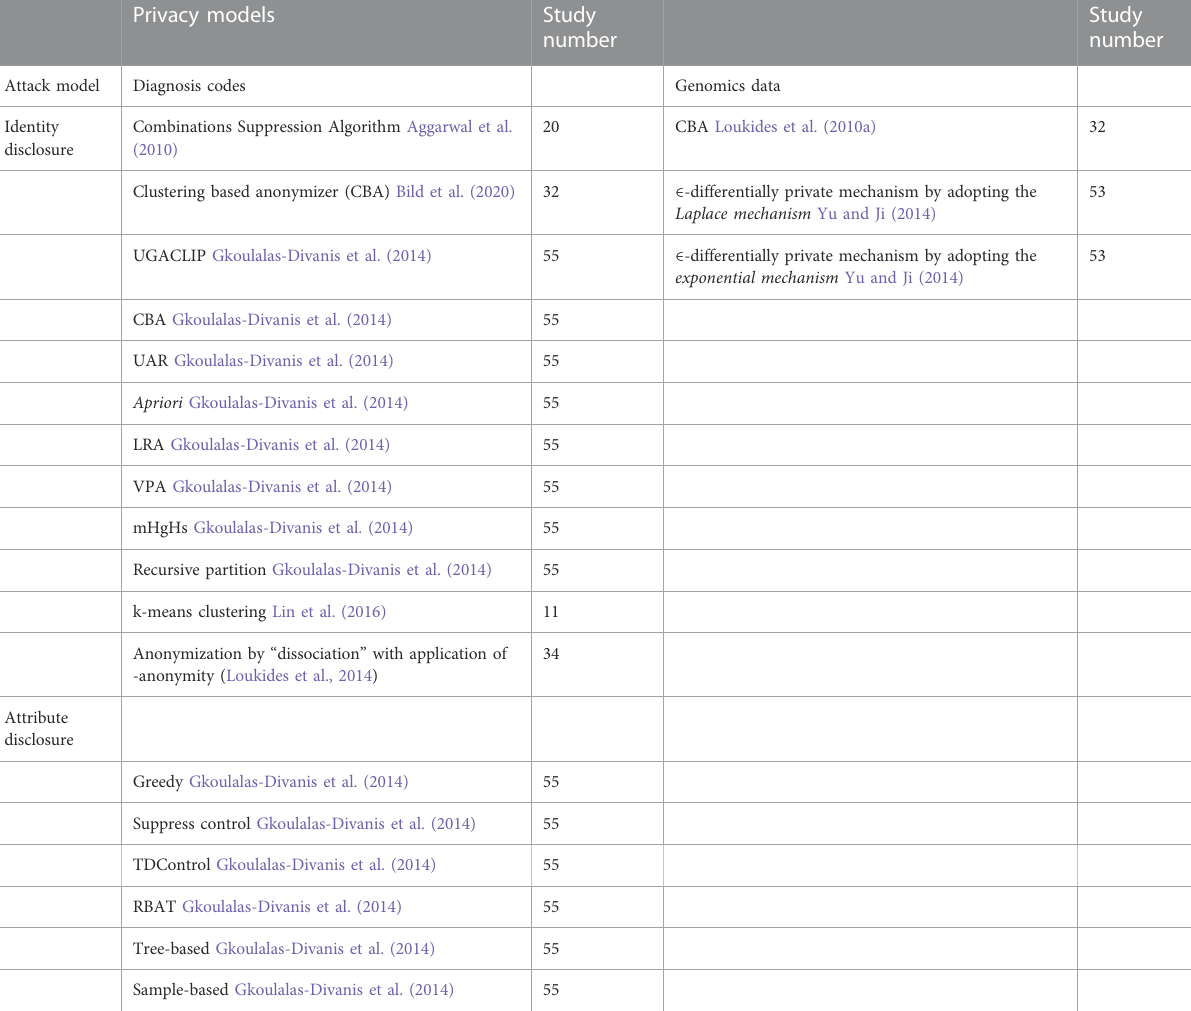
TABLE 2 Algorithms for the anonymization of structured healthcare data pertinent to diagnosis codes and genomic data. Privacy